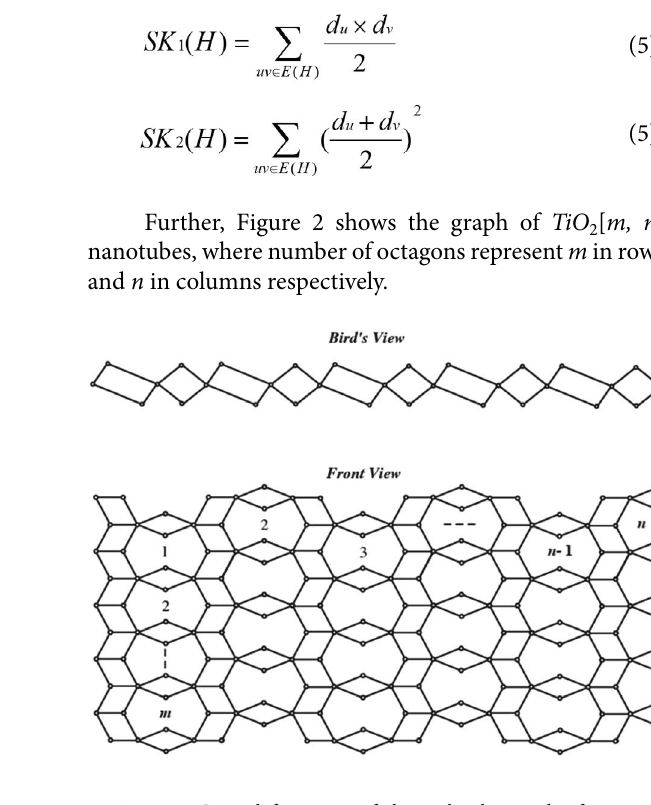
Figure 2. General formation of the molecular graph of titania TiO 2 [ m, n ] nanotubes